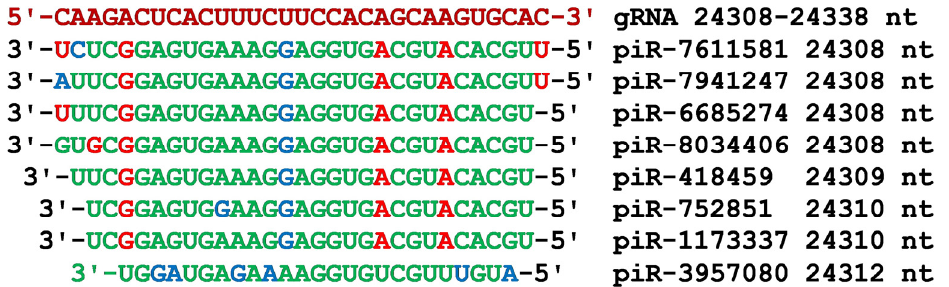
Figure 10. Nucleotide sequences of the seven piRNA BSs cluster in the CDS of gRNA from 24,308 nt to 24,338 nt and the piRNA nucleotide sequences. Note: The piRNA nucleotides that form canonical pairs with gRNA are highlighted in green and non-canonical pairs are highlighted in blue. The piRNA nucleotides that do not interact with gRNA are highlighted in red. The names of the piRNAs are followed by the beginning of their